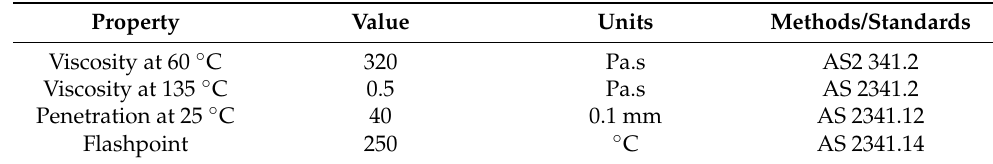
Table 1. Physical properties of C320 binder.